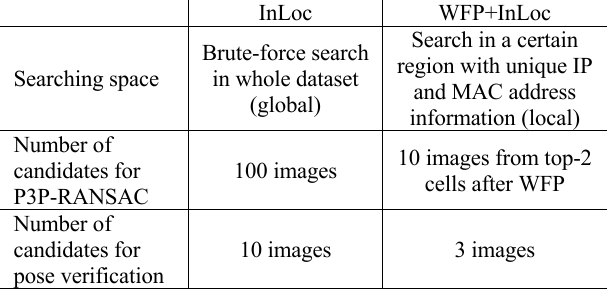
Table 1. Comparison of the original InLoc to our